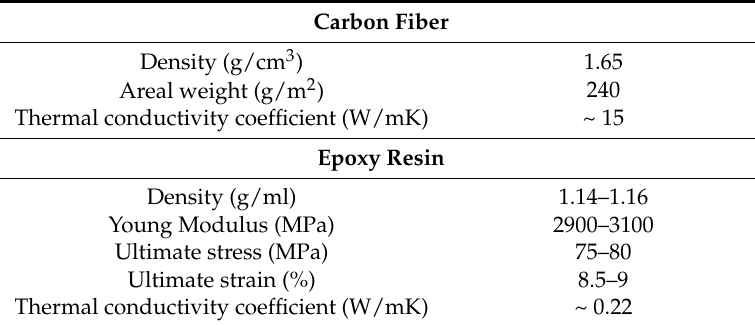
Table 1. Artificial defect geometry in the plates